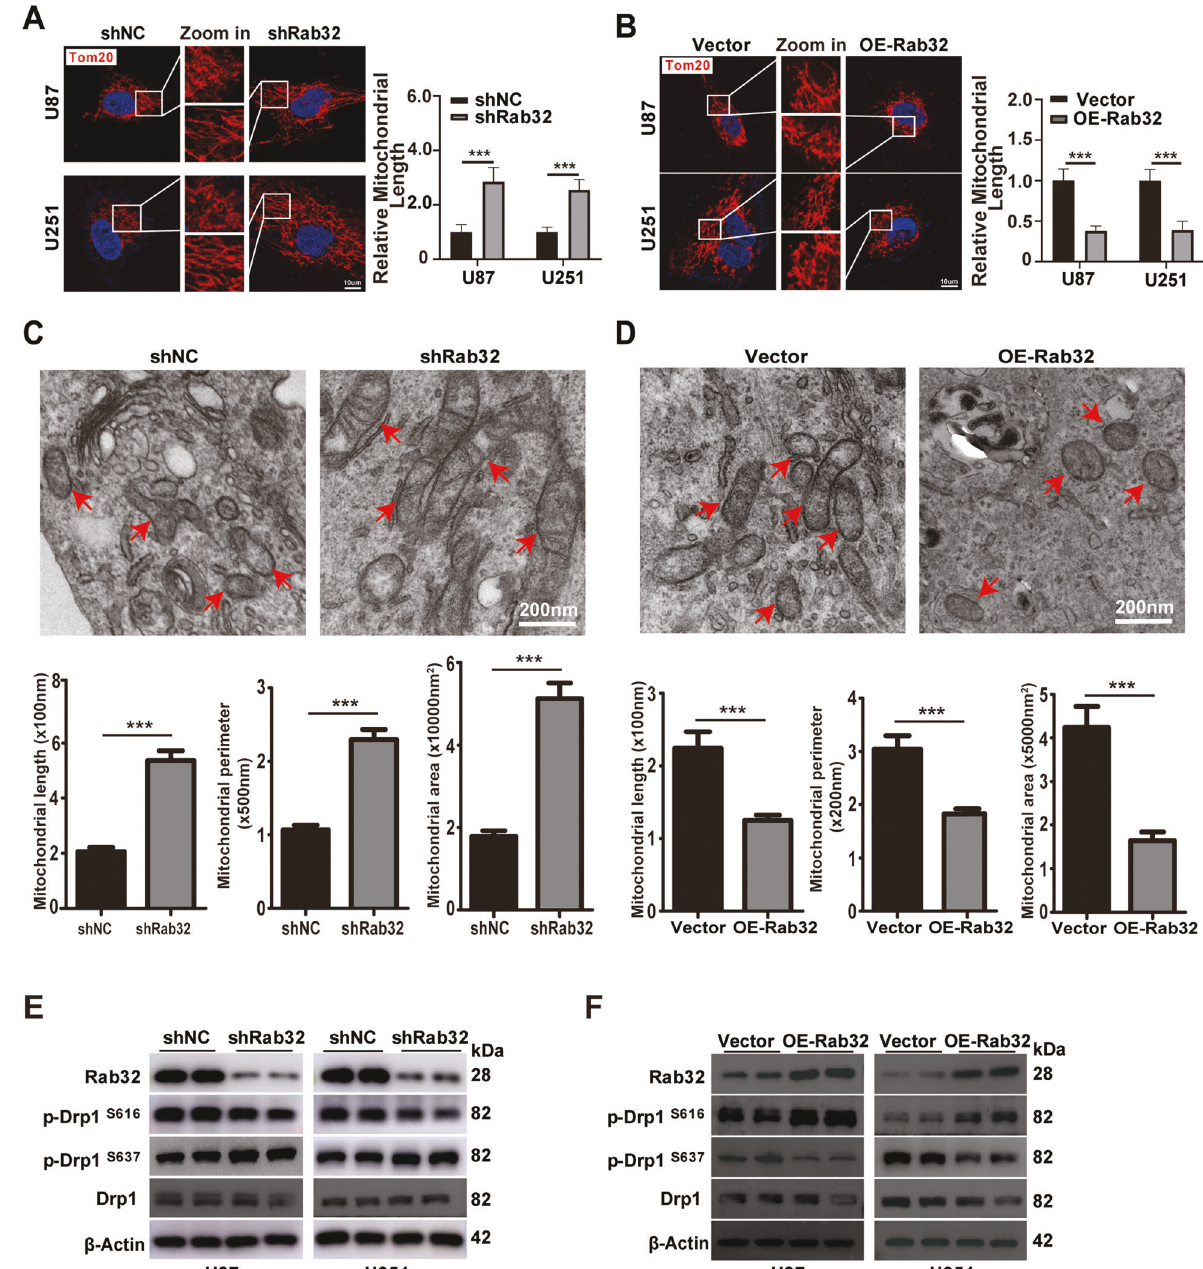
Fig. 3 Rab32 regulates mitochondrial fi ssion in glioma cells in a Drp1-dependent manner. A , B Representative immuno fl uorescence images of the mitochondrial network (Left panel) in treaded U87 and U251 cells. Red: Tom20, Bule: DAPI. Areas in the white squares are ampli fi ed and shown in the middle. The length of mitochondria was quanti fi ed by Image J (Right panel). N = 30 per group. Data shown are mean ± SD. Scale bar = 10 μ m. C , D Transmission electron microscopy (TEM) photomicrographs of U87MG cells with Rab32 knockdown or overexpression (upper panel). Quanti fi cation of mitochondrial length, perimeter and area using ImageJ software (lower panel). Mitochondria are highlighted in red arrows. N = 30 per group. Data shown are mean ±SD. E , F Western blot analysis of the protein levels of phosphorylated Drp1 at Ser637 (p-Drp1 S637 ) or Ser616 (p- Drp1 S616 ) sites in indicated U87 and U251 cells. β -Actin was used as a loading control. *** P <0.001 vs. NC groups. Drp1 transportation from cytoplasm to mitochondrial, then induced Drp1-mediated mitochondrial fi ssion, leading to the migration and invasion of GBMs. MAPK cascade. Given that ERK signaling induced Drp1 Rab32-mediated mitochondrial fi ssion is dependent on ERK 1/2 phosphorylation at serine 616 and led to mitochondrial fi ssion activation [29, 30], we wondered whether Rab32 regulates ERK signaling pathway.